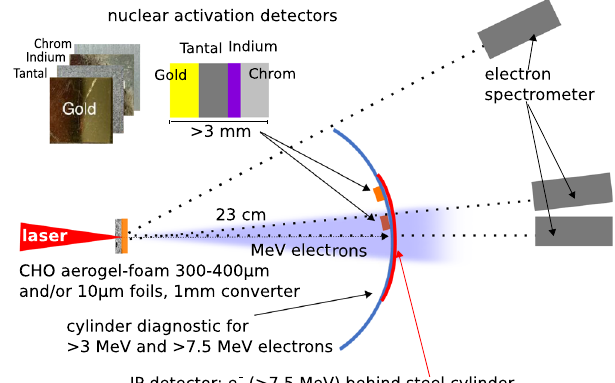
Fig. 1 Experimental set-up. Top view of the diagnostic set-ups used for irradiation of aerogel-foams (CHO) at 10 19 W/cm 2 (20 J in focal spot) laser intensity and conventional foils at ultra-relativistic intensity of ~10 21 W/cm 2 (40 J in focal spot). An imaging plate (IP) behind 6 mm thick steel cylinder was used to measure an angular distribution of electrons with energies above 7.5 MeV. Nuclear activation plates consisting of different materials were placed at the front of cylinder at 5 ∘ and 15 ∘ to the laser axis. Three 0.99 T magnetic spectrometer measured the energy distribution of accelerated electrons at 0 ∘ , 15 ∘ and 45 ∘ to the laser